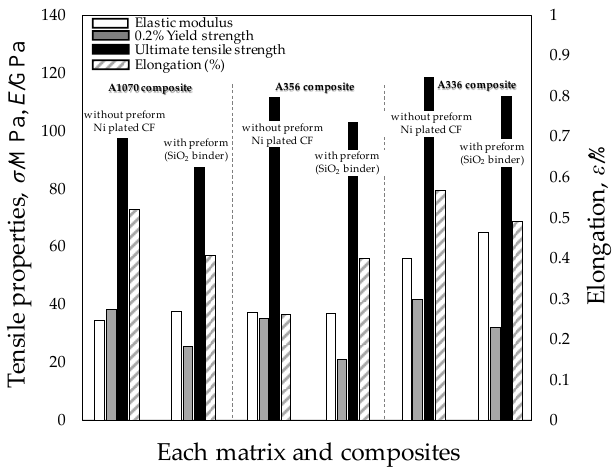
Figure 8. Tensile properties of Ni plated CSF/Al and Al alloy matrix composites compared to composite of preform manufacturing with SiO 2 binder.